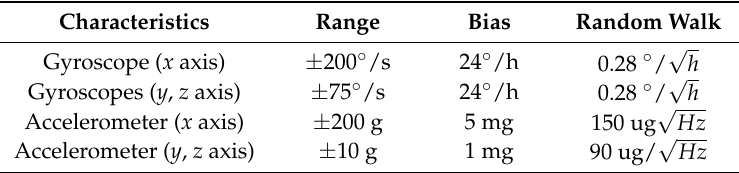
Table 3. Characteristics of MEMS-IMU (MIMU).